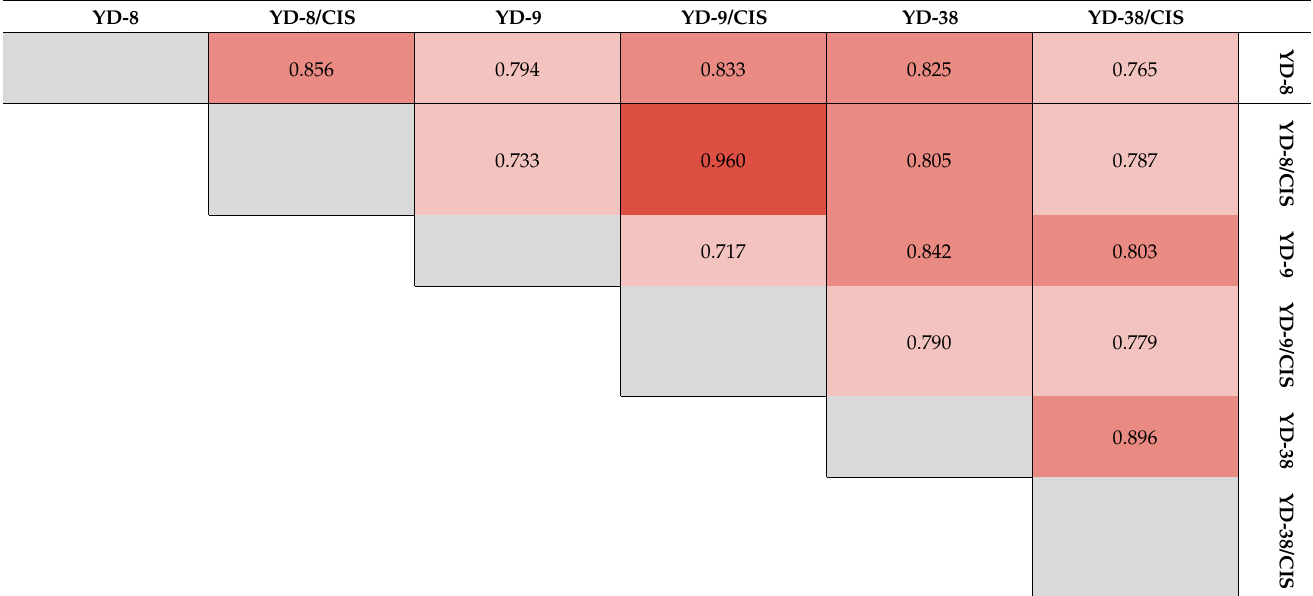
Table 3. The correlation between gene expressions of